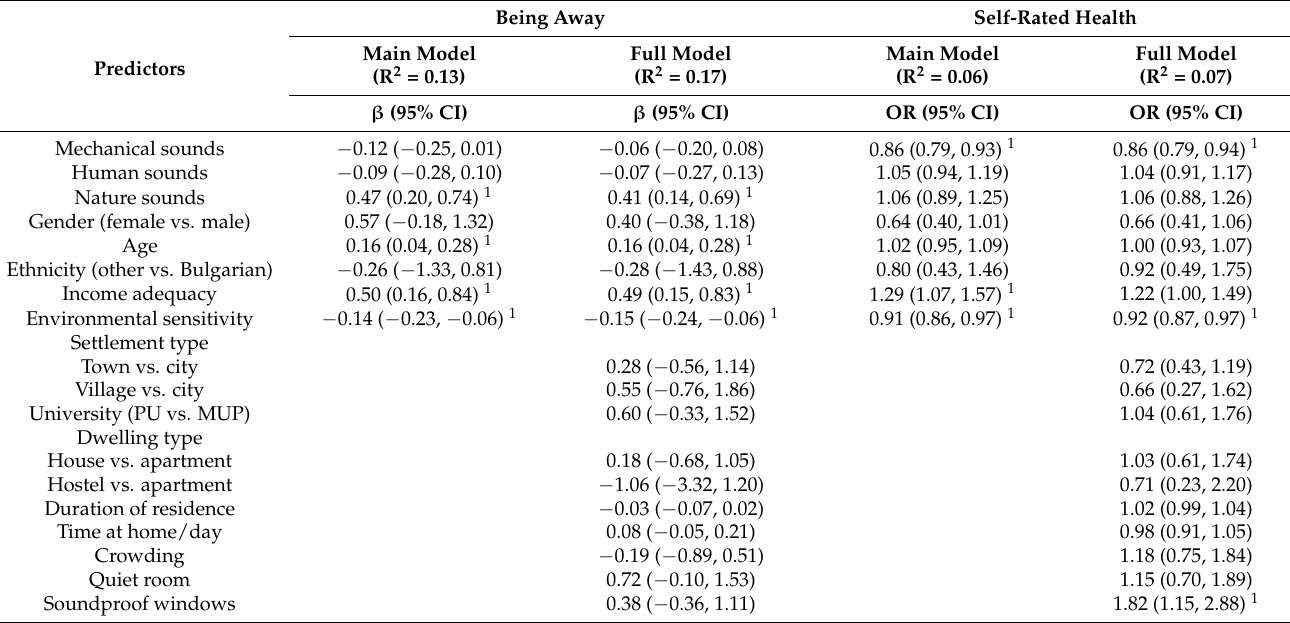
Table 5. Associations between perceived sounds and “being away” and self-rated